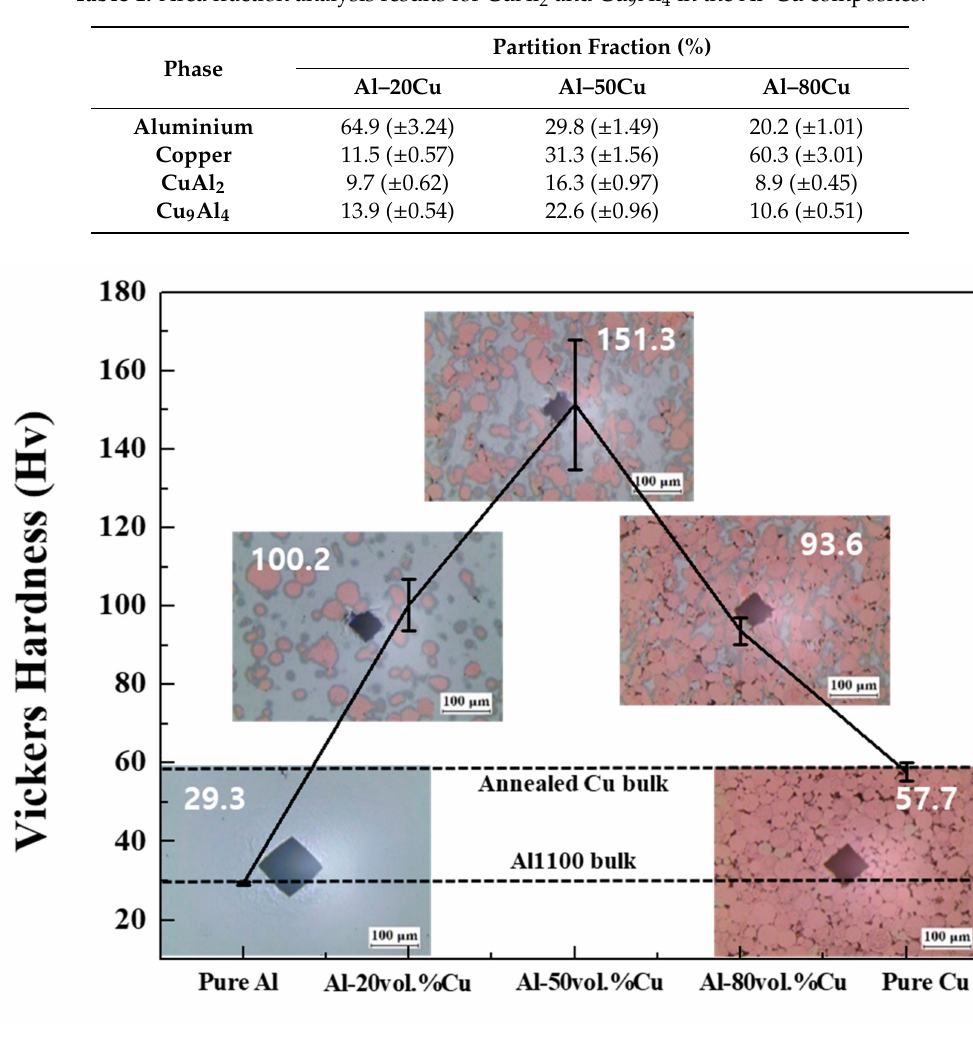
Figure 7. Vickers hardness of the fabricated pure Al, pure Cu, and Al–Cu